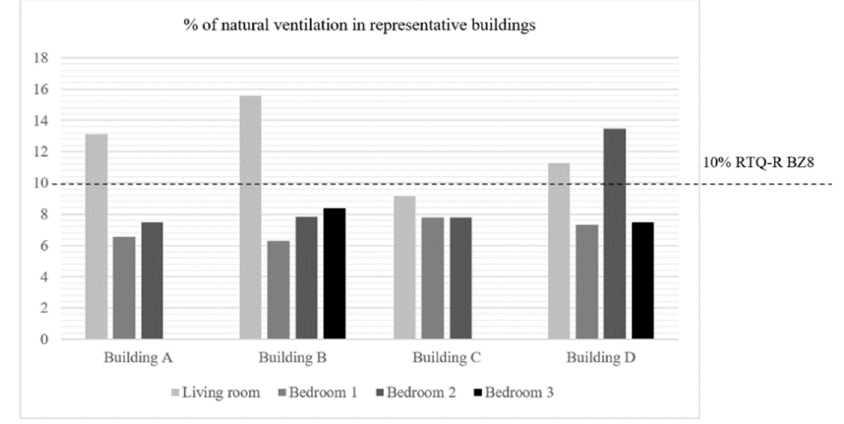
Figure 6. Percentage of natural ventilation in the EUSs of the representative buildings.